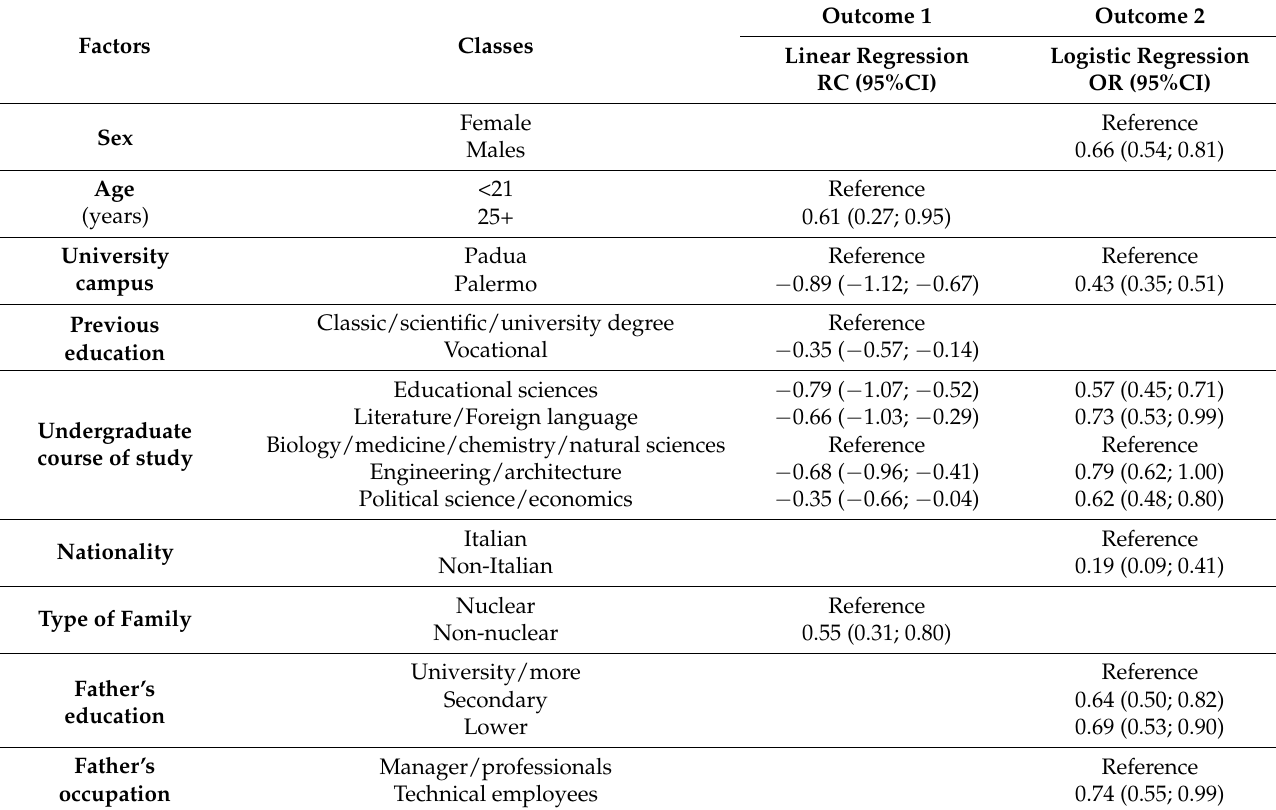
Table 6. Results of multiple linear regression (outcome 1) and multiple logistic regression (outcome 2): regression coefficient (RC) and odds ratio (OR) with